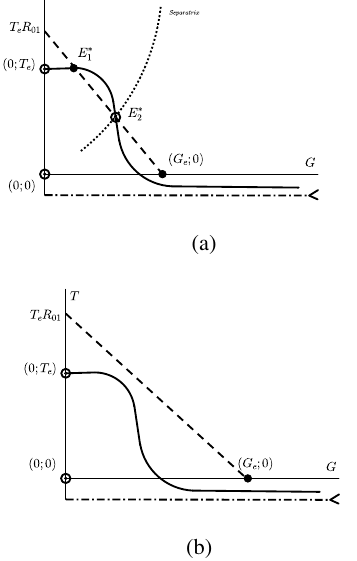
Fig. 6: Different equilibria and their stability/instability properties when R 01 > 1 and ω ( G e ) R 10 < 1 . Opposite to Fig 3 , we have two situations. (a) shows two feasible internal equilibria, the lower equilibrium is unstable and the upper is stable. It presents the bistability between the upper coexistence equilibrium and the grassland equilibrium. We could not observe this situation previously, when we used the Holling type II or a linear form of ω . Other point is that in (b), grassland is GAS. Note that this is not the case with Holling type II.